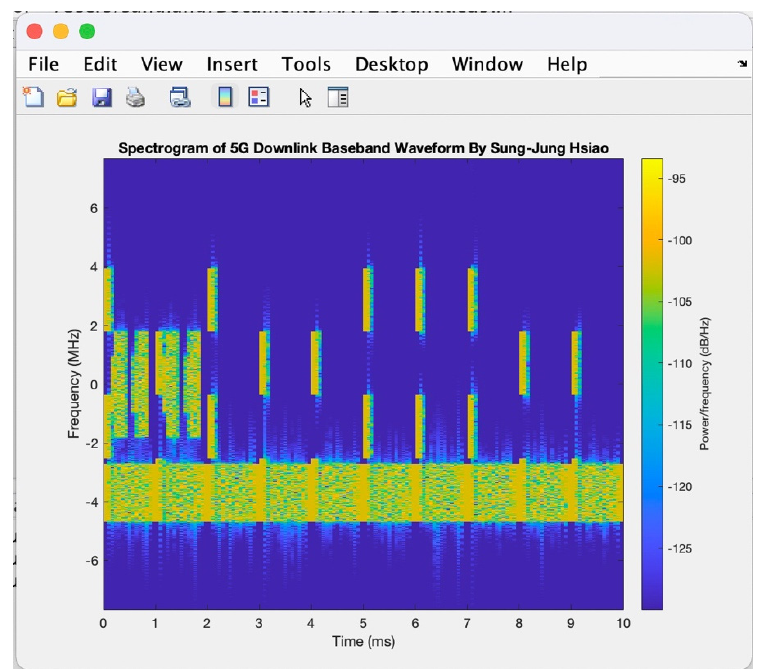
Figure A6. Spectrogram of a 5G down-link baseband waveform with a PRB ranging from 0 to 10. Multiple instances of physical channels and signals can also be defined. Our ap- proach created a second instance of the PDSCH configuration object and set the allocation to span PRB 40 to 50 and OFDM symbols 2 to 10. Our research then assigned the second PDSCH configuration to the waveform configuration, and the system generated the wave- form shown in Figure A7.